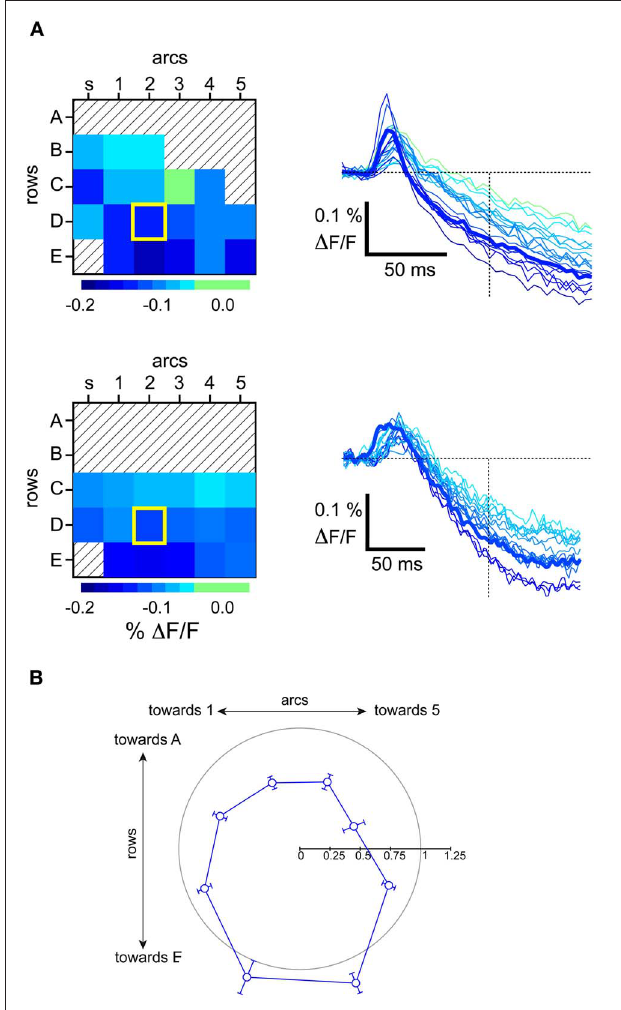
FIGURE 9 | Polarity of hyperpolarizing response observed in the up-state. (A) Examples of barrel-column maps from individual experiments showing the level of hyperpolarizing VSD signal at the indicated time after a stimulus, and the corresponding VSD traces. Principal barrel column corresponding to the deflected whisker is outlined with a thick yellow square. (B) Population average of the direction of inhibition. Angles are measured from the barrel corresponding to the first stimulated whisker. Before averaging, data from individual experiments were normalized to the hyperpolarizing level observerd in the stimulated whisker’s barrel-column trace. The gray circle has a radius of 1 on this